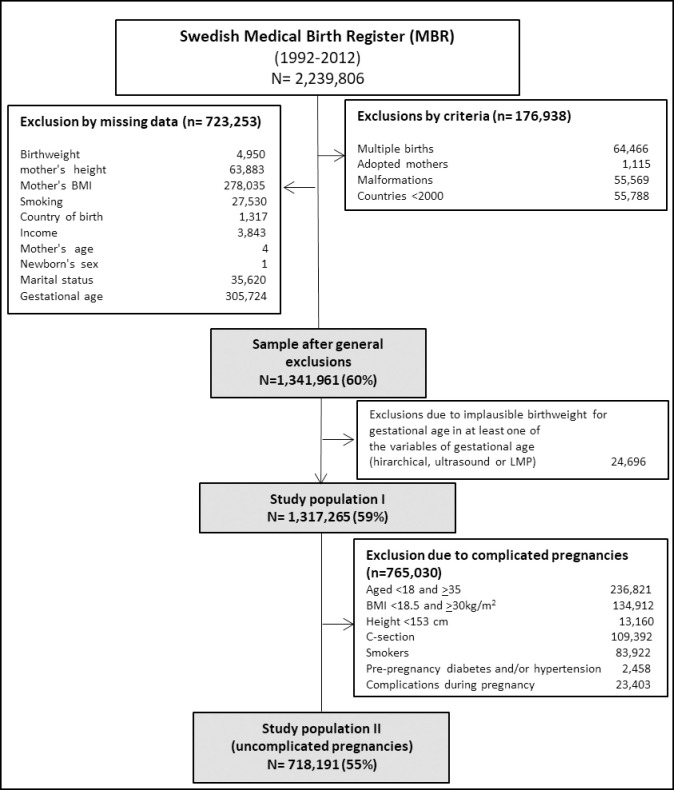
Selection flow and study population.